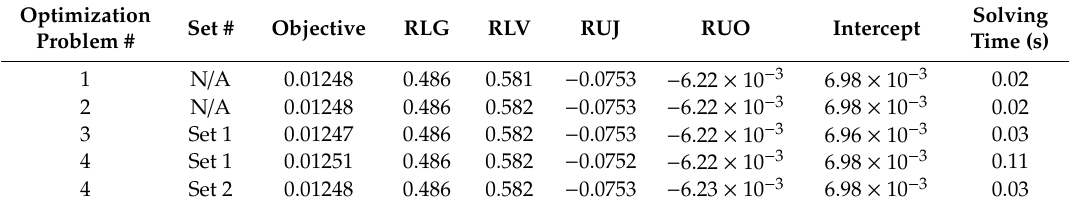
Table 1. Optimization outputs: estimating CVaR with the linear regression, α = 0.75.